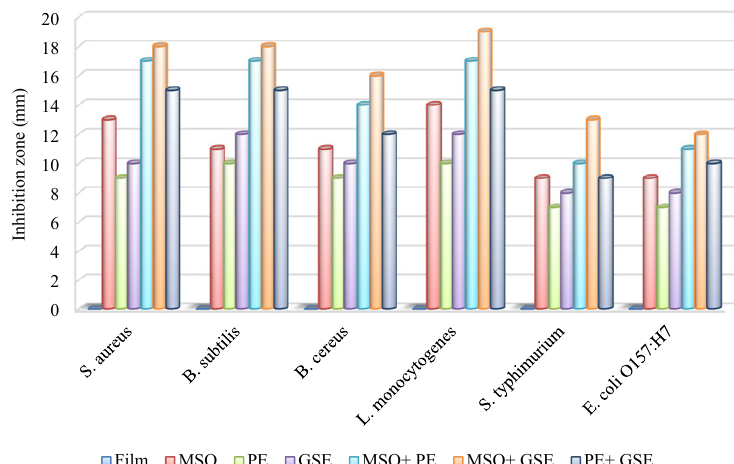
Fig. 6. The antibacterial activities of nanochitosan film incorporated with M. spicata essential oil (MSO), pomegranate peel extract (PE) and grape seed extract (GSE) electron microscope study and FTIR showed good interaction of investigated compounds with